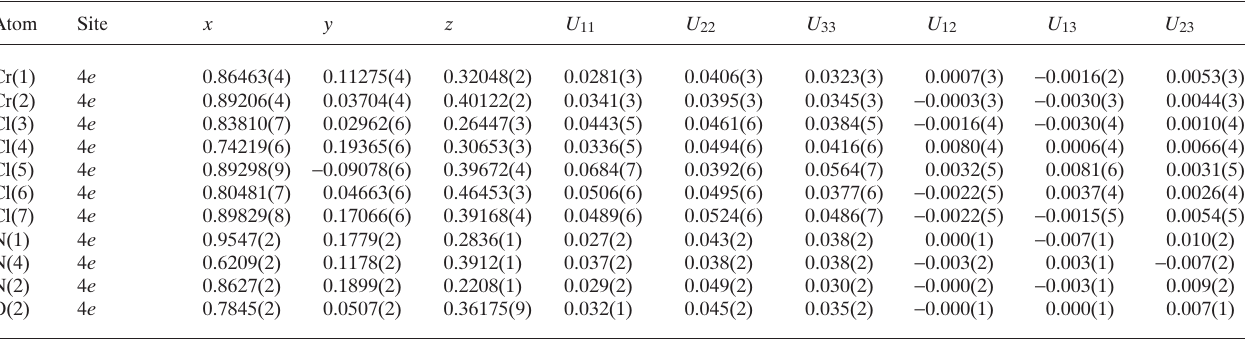
Table 3. Atomic coordinates and displacement parameters (in Å 2 )